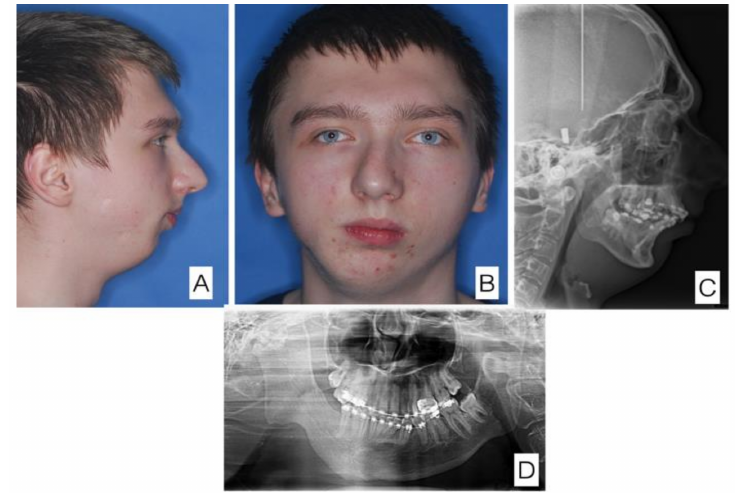
Figure 5. A 15-year-old patient with temporomandibular joint ankylosis on the right side after Staphylococcus aureus infection at age 5. Condition prior to osseodistraction of the right mandibular ramus (the first stage of the treatment). ( A ) Lateral view of the face, ( B ) anterior view of the face, ( C ) cephalometry, ( D ) orthopantomogram.